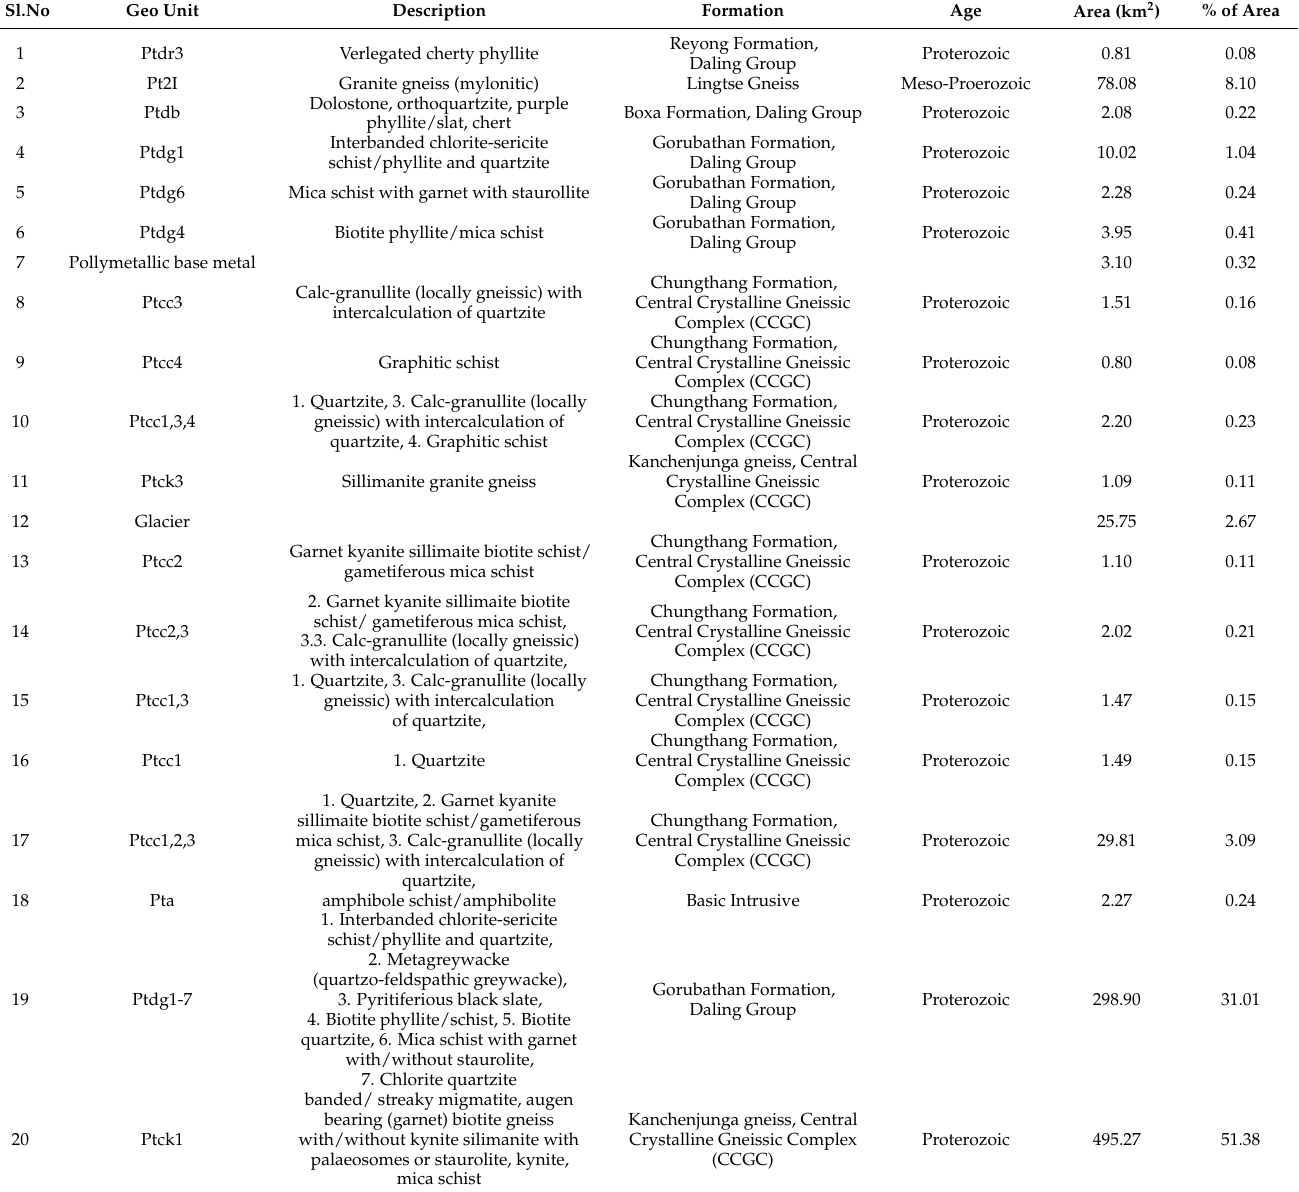
Table 1. Lithological units, characteristics, and their areal extension of East